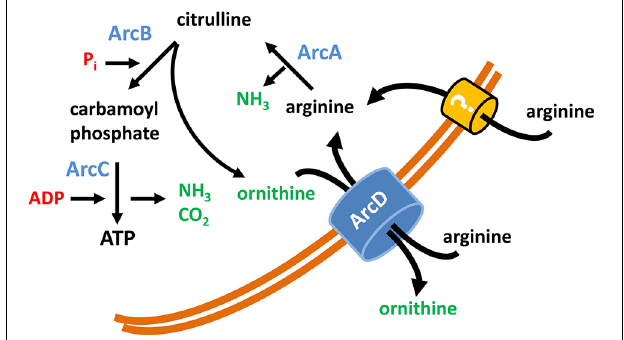
FIGURE 5 | Model of the function of ArcD as part of the S. suis ADS. The core ADS enzymes (ArcA, ArcB, ArcC) facilitating the conversion from arginine to ornithine are depicted in blue. Metabolic intermediates are indicated in black. The input of energy in terms of phosphate derivatives (P i , ADP) are marked in red, non-catabolized and excreted products have a green color. ArcD, located in the bacterial membrane, facilitates an arginine/ornithine antiport. The occurrence of an alternative arginine transporter is illustrated by a question